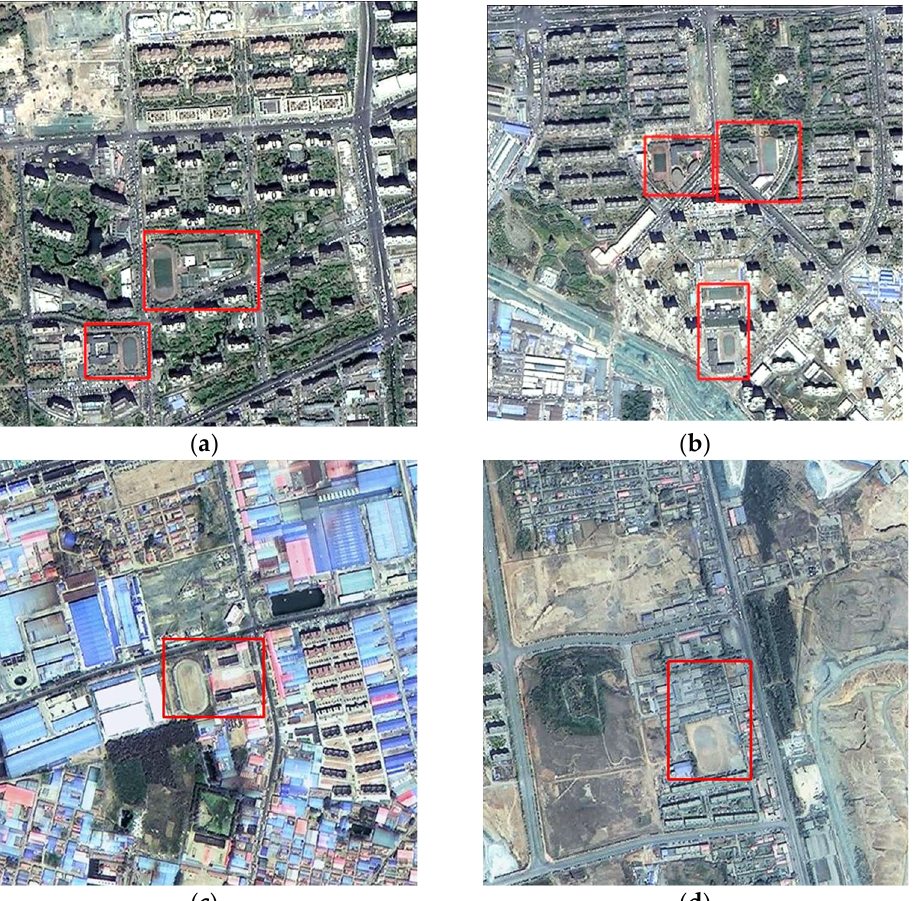
Figure 2. Samples of PSSs in different regions: ( a , b ) PSSs in urban regions; ( c , d ) PSSs in remote regions.